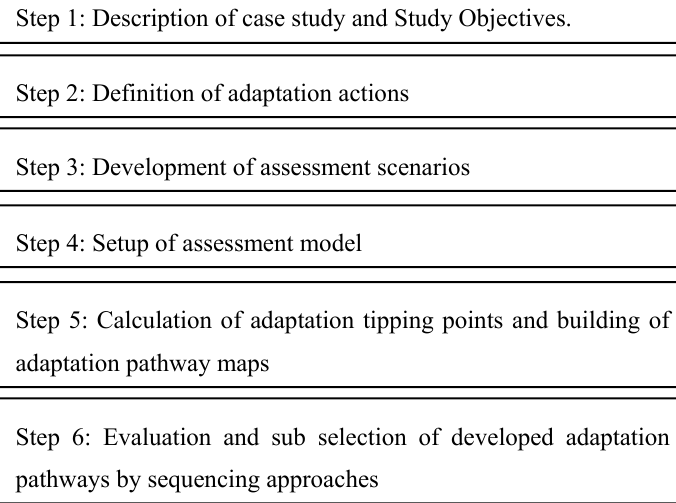
Figure 1. Overall framework of the study.